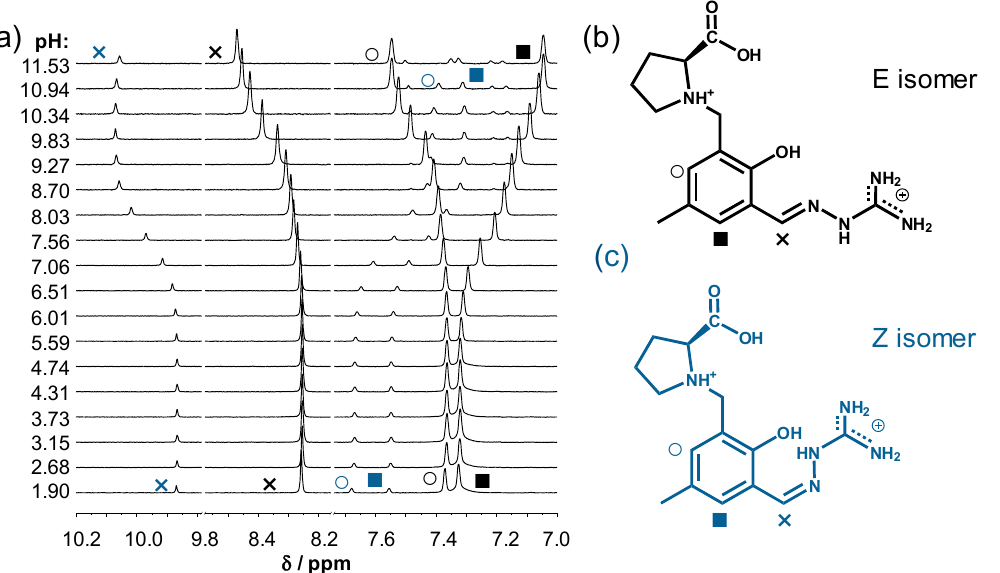
Figure 3. ( a ) 1 H NMR spectra of Pro-SISC-Me in the low field region recorded in aqueous medium at the indicated pH values, and structure for the H 3 L 2+ forms of the ( b ) E and the ( c ) Z isomers with the notation of the symbols of the CH protons of the salicylaldehyde aminoguanidine moiety assigned to the peaks in the NMR spectra in ( a ). ( c ligand = 1.0 mM; 10% ( v / v ) D 2 O/H 2 O; pH = 2.2–12.2; T = 25 °C; I = 0.10 M (KCl)).